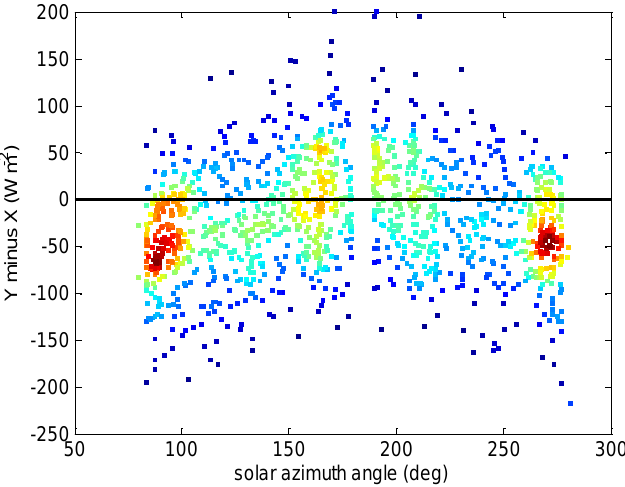
Figure 9. Residuals (McClear DNI minus ground measured DNI) versus the solar azimuth angle for Aswan under cloud-free